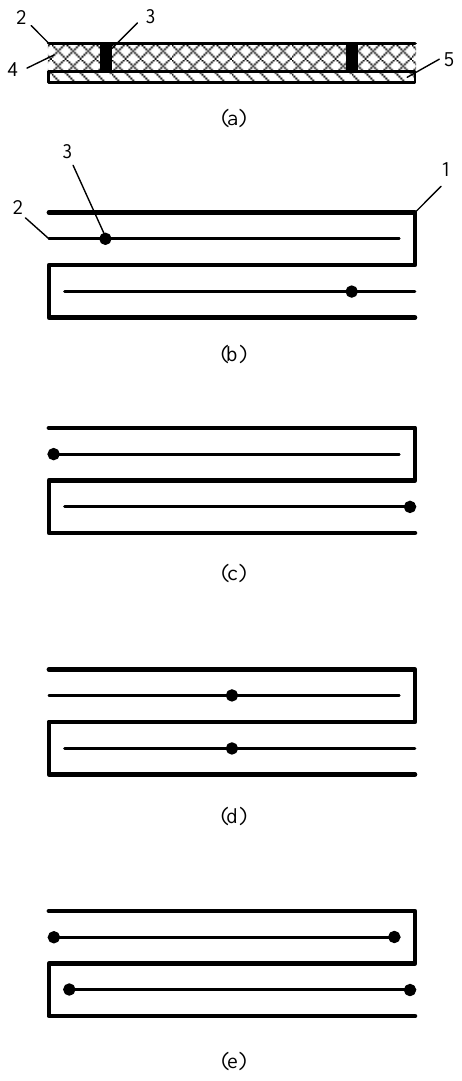
Fig. 2. (a) cross-section and the top views of meander slow-wave system when grounded via positioned at: (b) – the point between the edge and the center (like in cross-section view); (c) – one edge; (d) – center; (e) – both edges; 1 – meander-shape conductor; 2 – additional shield; 3 – grounded via; 4 – dielectric substrate; 5 – grounded external shield.